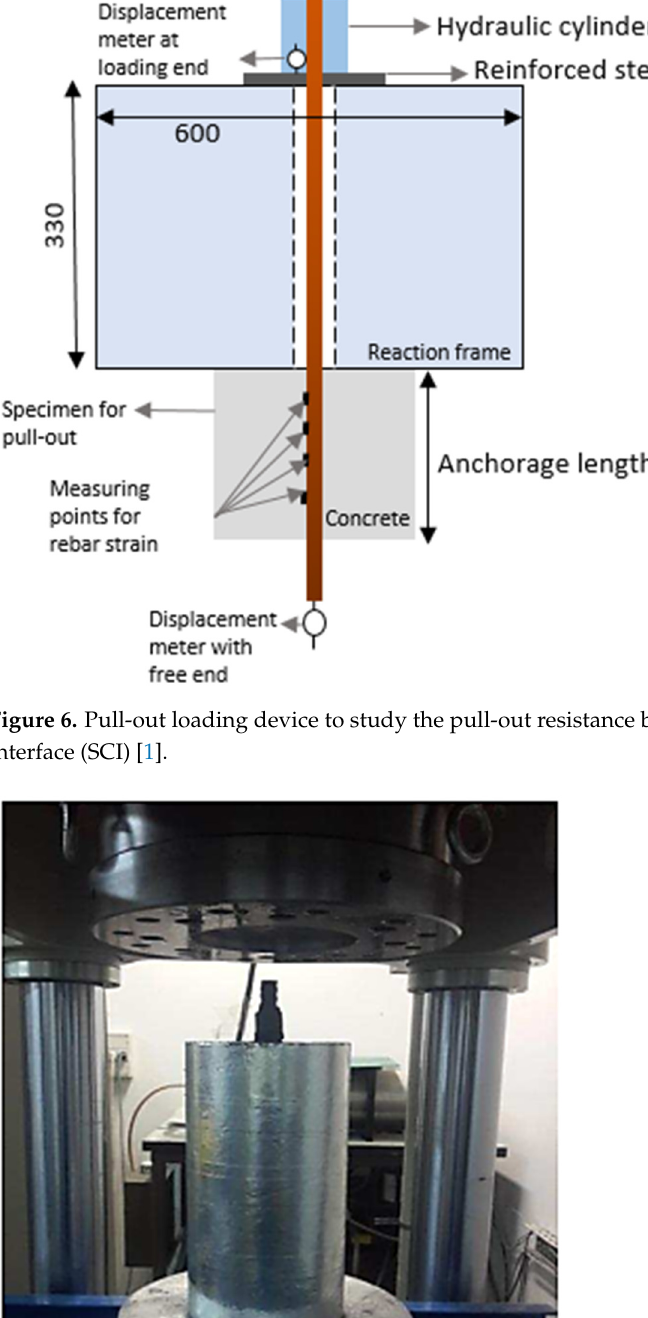
Figure 8. Tensile testing instrumentation for tie beam specimen (Reproduced with permission from reference [59,60]). 4.2. Mechanism Analysis of Interface Bond in a Pull-Out Setup Researchers have conducted pull-out tests to verify the main physical factors that a ff ect both the ultimate load of the bond interface and the bond strength of a reinforced concrete structure. Some of these factors are interrelated in which more than one factor will impact the bond at the SCI. The various factors a ff ecting the bond at the SCI are de- scribed below.